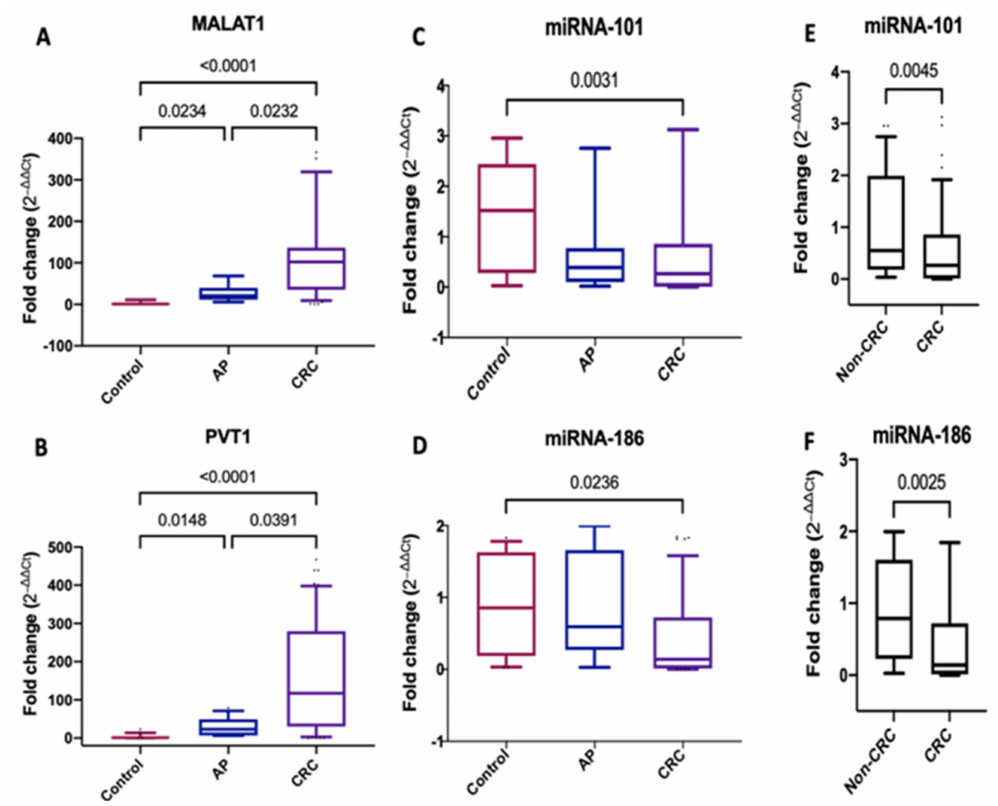
Figure 1. Serum expression levels of MALAT1 , PVT1 , miRNA-101 and miRNA-186 . ( A – D ) Fold change of serum MALAT1 , PVT1 , miRNA-101 and miRNA-186 expression levels in patients with CRC (n = 140) and adenomatous polyps ( n = 40) compared with healthy controls ( n = 100). ( E , F ) Fold change of miRNA-101 and miRNA-186 expression levels in CRC ( n = 140) versus non-CRC ( n = 140). For the control samples, the 2 − ∆∆ ct was calculated by subtracting each control value from the average control. Data were expressed as box blot; the box represents the 25–75% percentiles; the line inside the box represents the median and the upper and lower lines representing the 10–90% percentiles. p < 0.05 means statistical